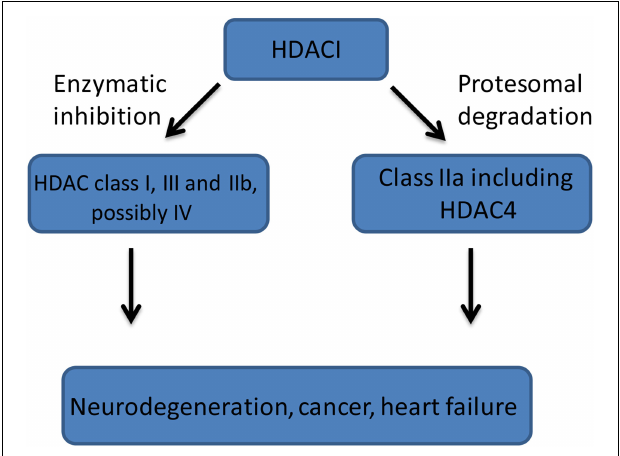
FIGURE 2 | A general mechanism of HDACIs (HDAC Inhibitors) action. Class I (HDACs: 1, 2, 3, 8), Class IIa (HDACs: 4, 5, 7, 9), Class IIb (HDACs: 6, 10), Class III (sirtuins 1-7), and Class IV